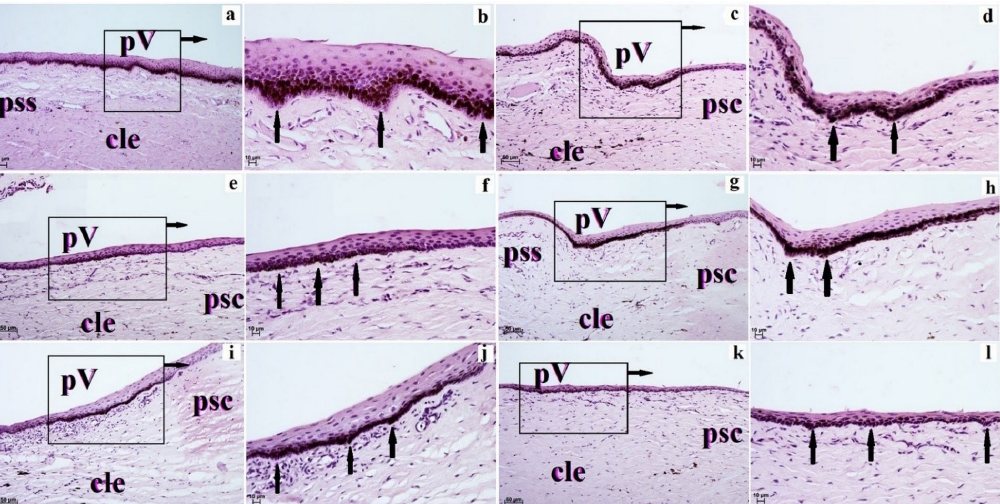
Figure 2. The photomicrograph of the cornea in the examined ruminants. H&E stain. ( a )—common wildebeest, ( b )—Kirk’s dik ‐ dik, ( c )—Natal red duiker, ( d )—scimitar oryx, ( e )—sitatunga, ( f )—Philippine spotted deer, ( g )—Père David’s deer, ( h )—moose, ( i )—reindeer, ( j )—reticulated giraffe, ( k )—okapi, ( l )—Balabac mouse-deer, ( m )—alpaca. Scale bar: ( a , h ) = 50 µ m; ( d , f – m ) = 20 µ m; ( b , c , e ) = 10 µ m. plm—posterior limiting membrane (Descemet’s membrane), psc—proper substance of cornea.